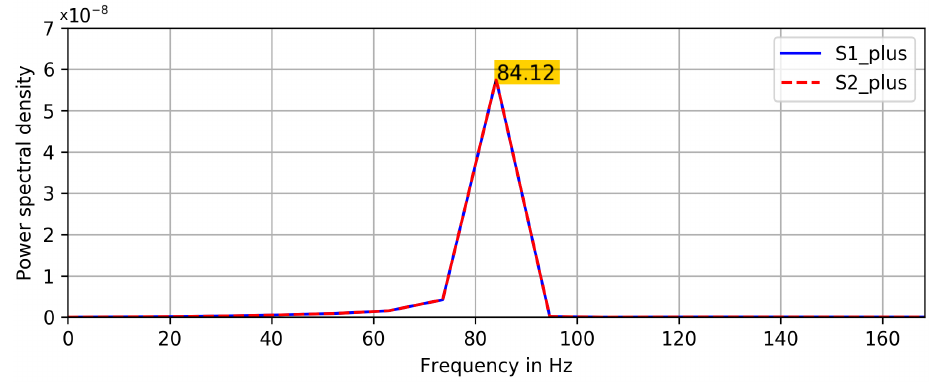
Figure 13. Discrete Fourier analysis of the displacement signal. The highest peak at 84.12 Hz in the frequency analysis is in good agreement with the estimated excitation frequency. A discrete Hilbert transformation is applied on the displacement signal to calculate the phase shift, see Figure 14.